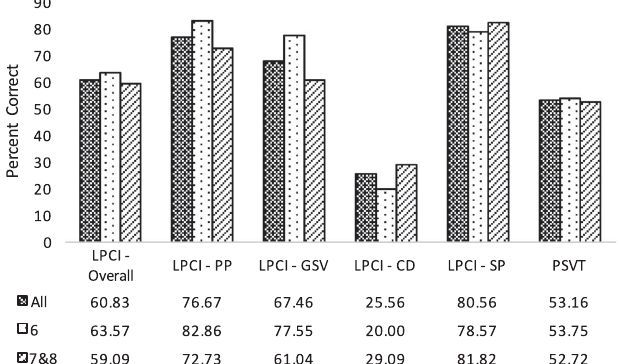
FIG. 3. LPCI (overall and by domain) and PSVT post-tests percent correct for 6th grade teachers ( n ¼ 8 ) and 7th – 8th grade teachers ( n ¼ 11 ).